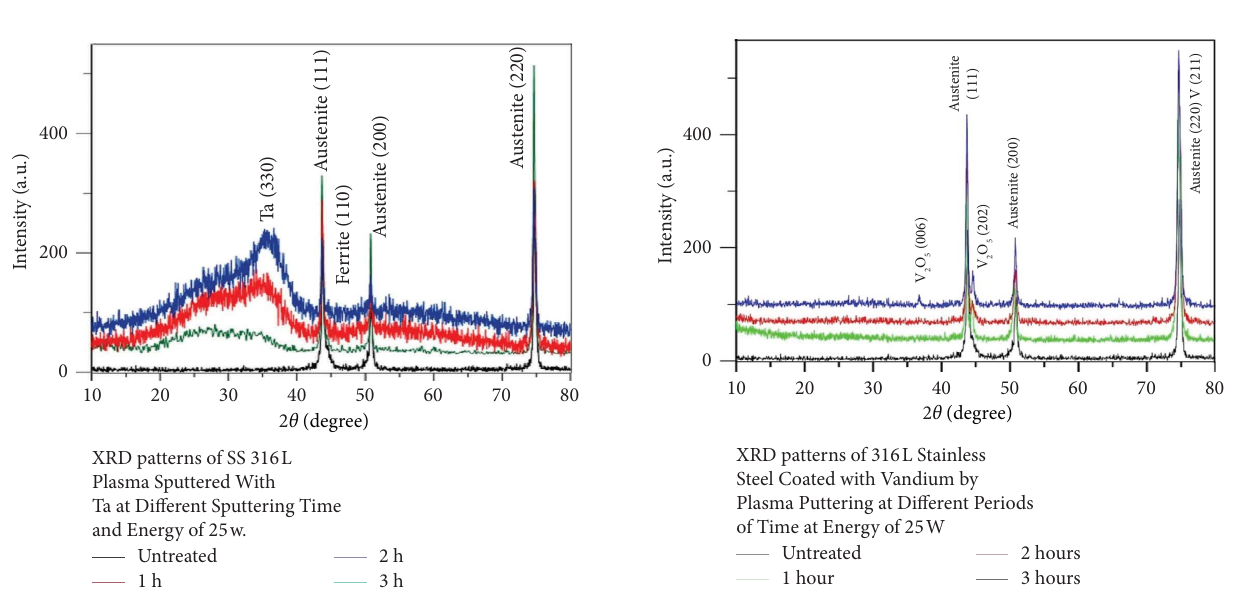
Figure 2: XRD patterns of 316L SS plasma sputtered with Ta at diferent sputtering times.